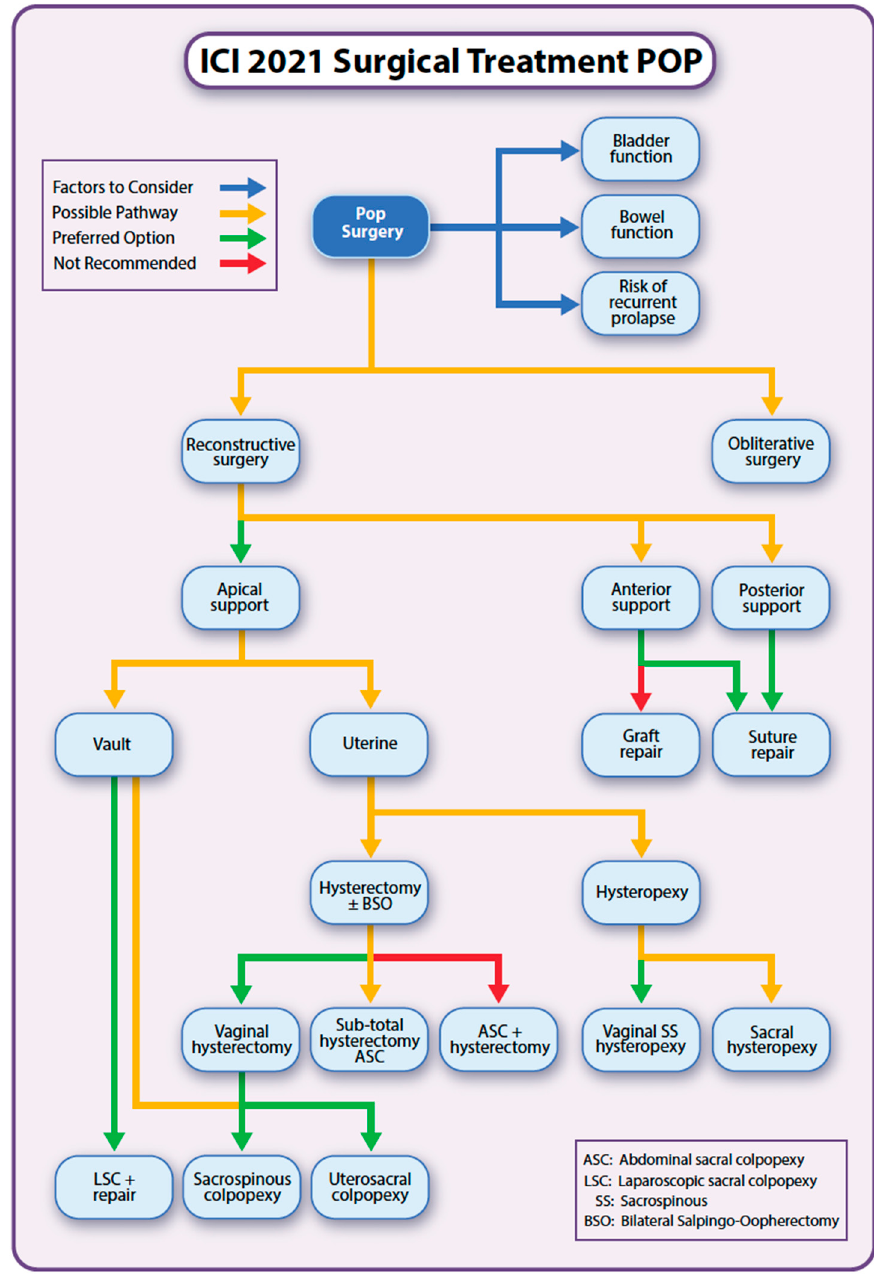
Figure 3. ICI 2021 pathways for surgical treatment of POP.